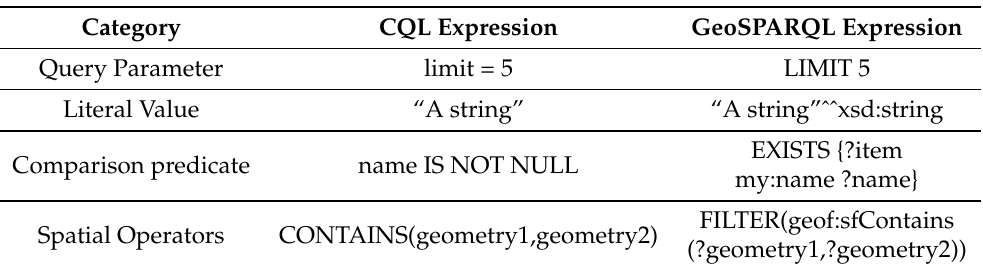
Table 1. Examples of equivalences between CQL and GeoSPARQL for a literal value, query parame- ters, and comparison predicates in FILTER expressions. Category CQL Expression GeoSPARQL Expression Query Parameter limit =